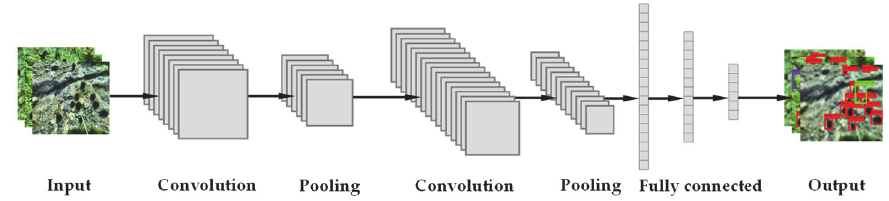
Figure 1. The structure of convolutional neural